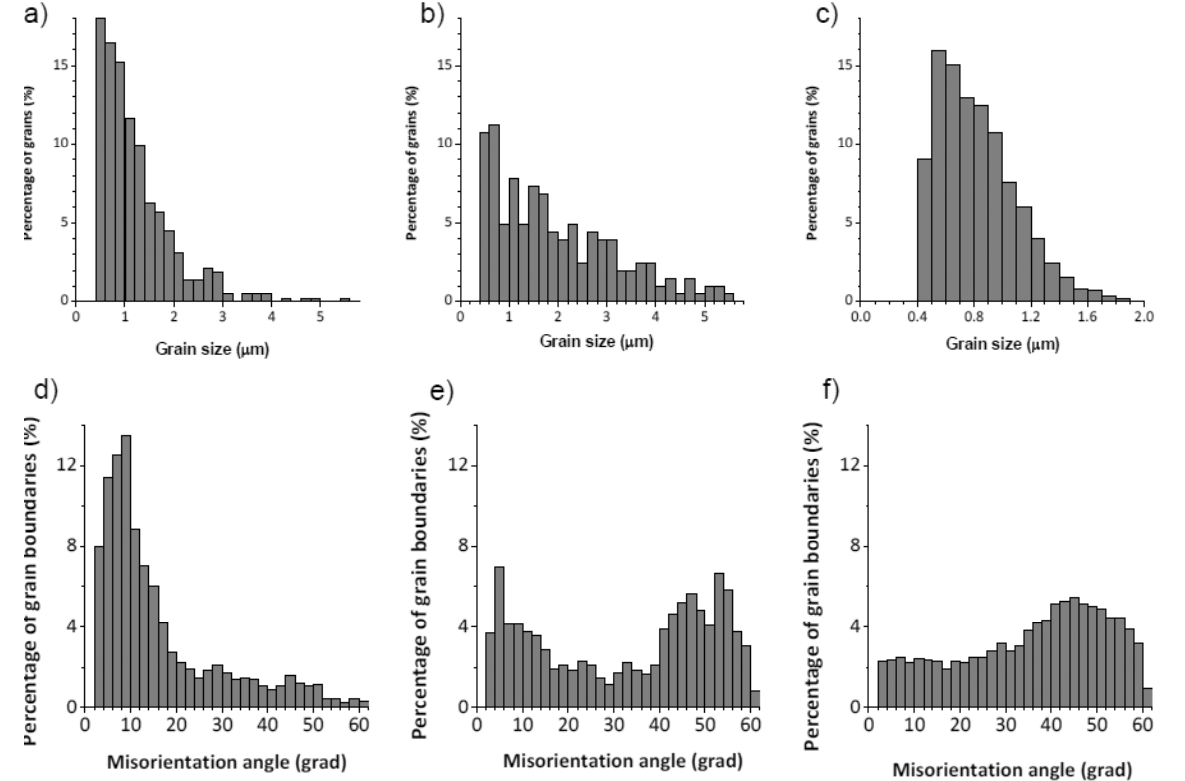
Fig. 4. Grain size distribution (a, b, c) andgrain boundary misorientation angle distribution (d, e, f) of Al– 0.4Zr(wt.%) alloy in C–R state (a, d) after AG treatment (b, e) after AG–HPT treatment (c, f).